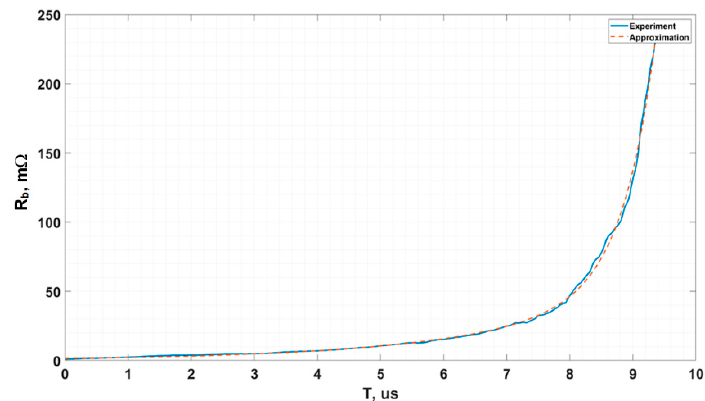
Figure 4. Experimental and calculated (dashed) dependence of the resistance of the circuit breaker from time to time.